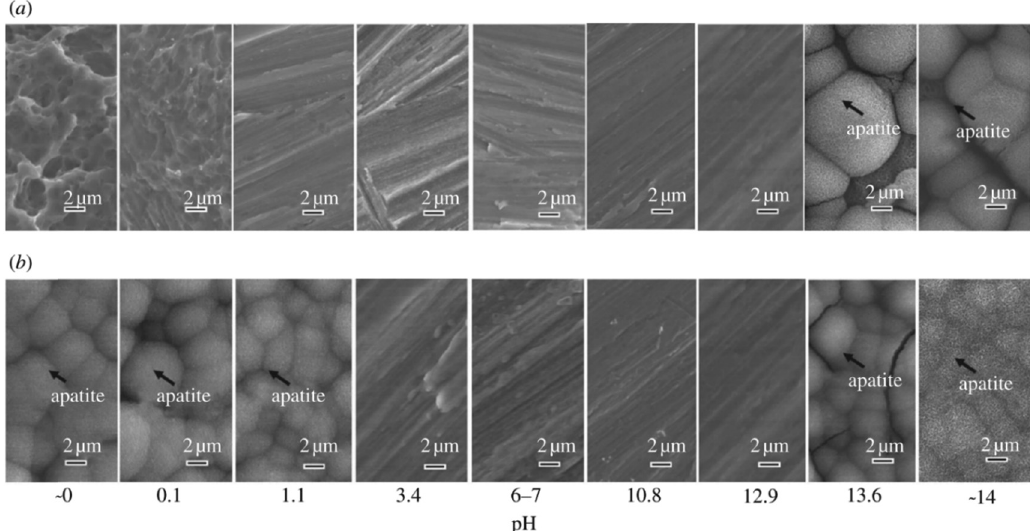
Figure 4: FE - SEM images of the Ti surface exposed to solutions with di ff erent pH values and subsequently immersed in SBF for 3 days ( a ) before and ( b ) after heat treatment [ 67 ] . Copyright 2012, The Royal